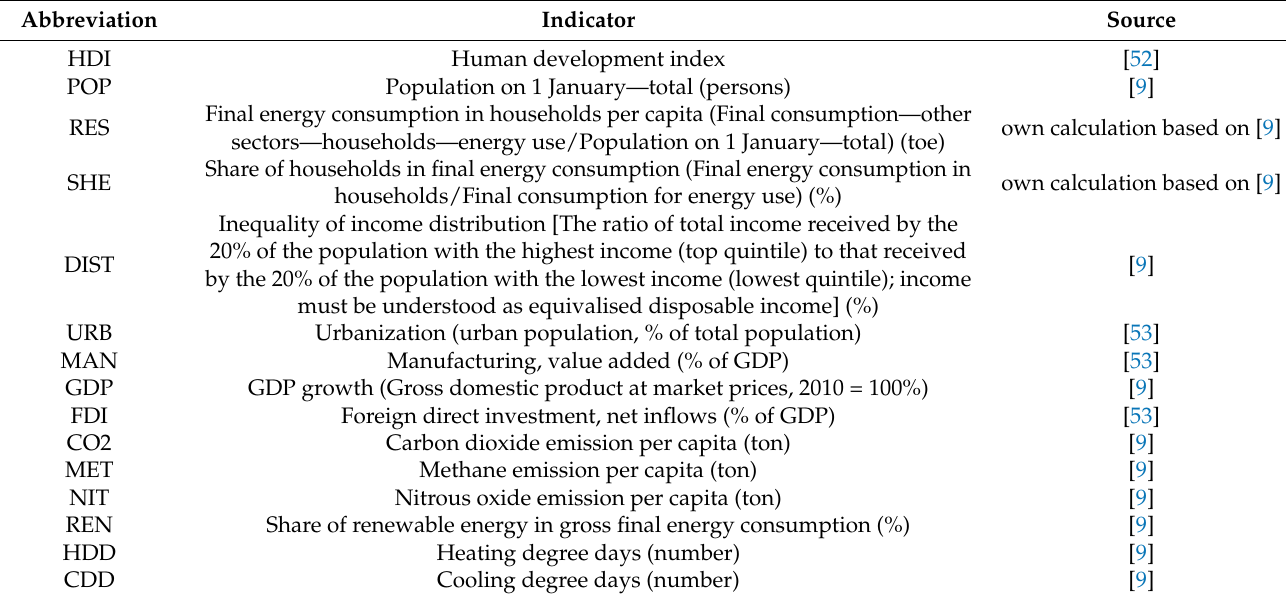
Table 1. Applied data and their